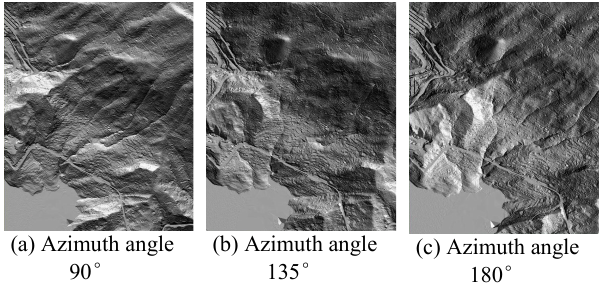
Fig.4 Hillshade maps of Zhangjiawan landslide